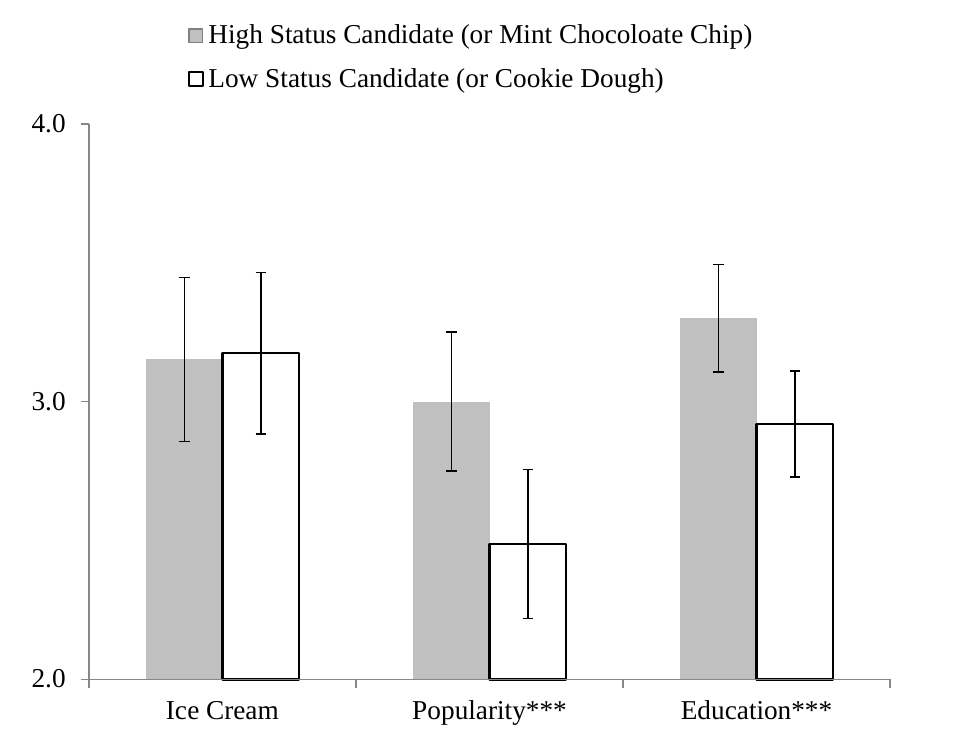
Figure 2: Perceptions of “gifted with respect to contrast sensitivity,” study